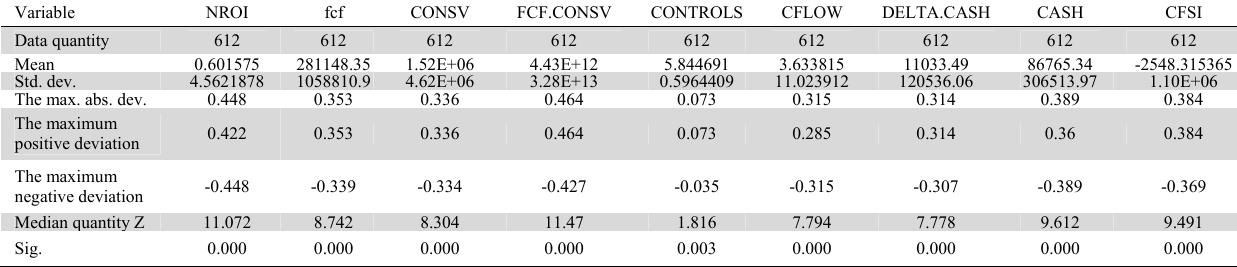
The summary of Kolmogorov-Smirnove test